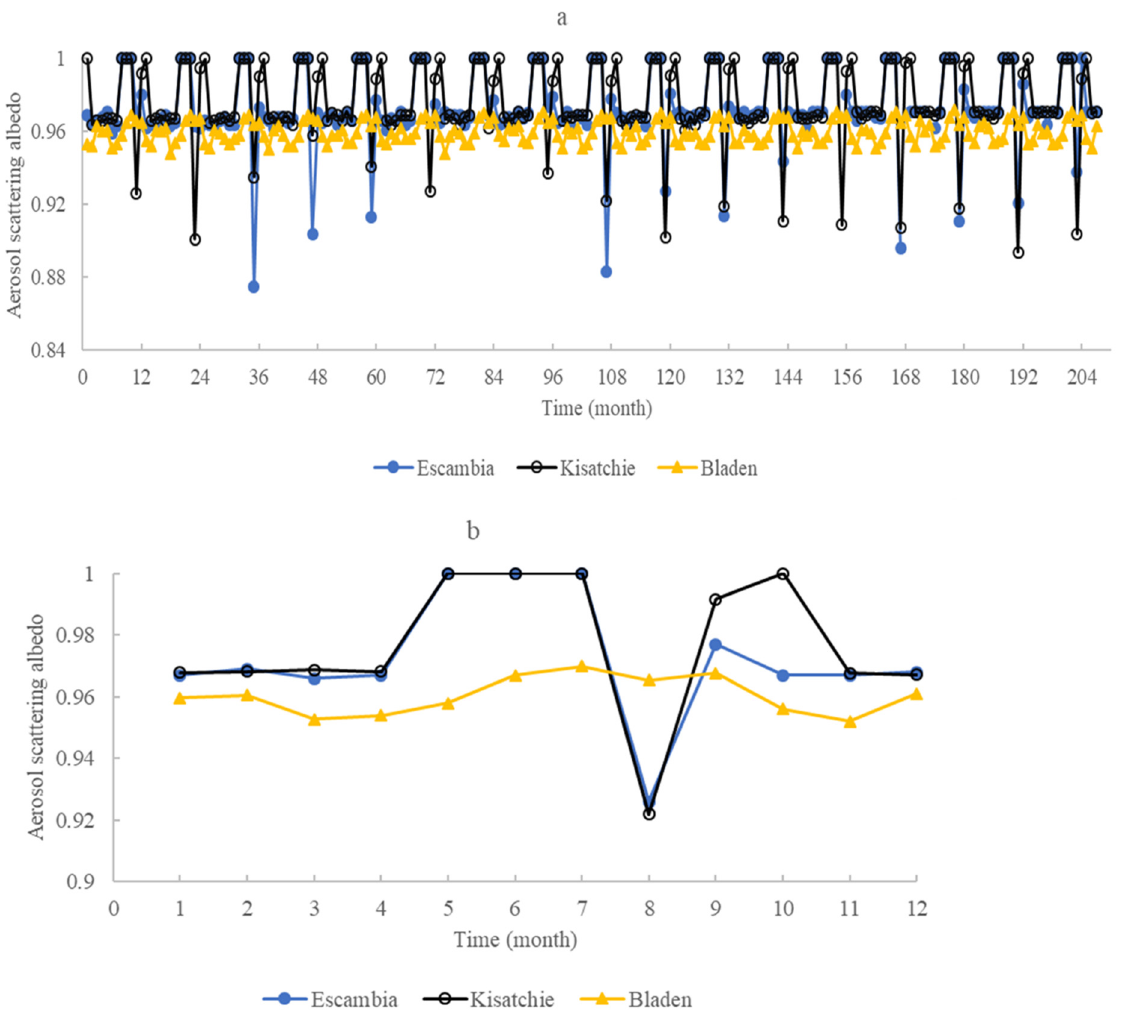
Figure 2. Dynamics of aerosol single scattering albedo at 483.5 nm in Escambia, Bladen, and Kisatchie. ( a ) Monthly and yearly dynamics of aerosol single scattering from October 2004; ( b ) The integrated monthly average of aerosol single scattering.